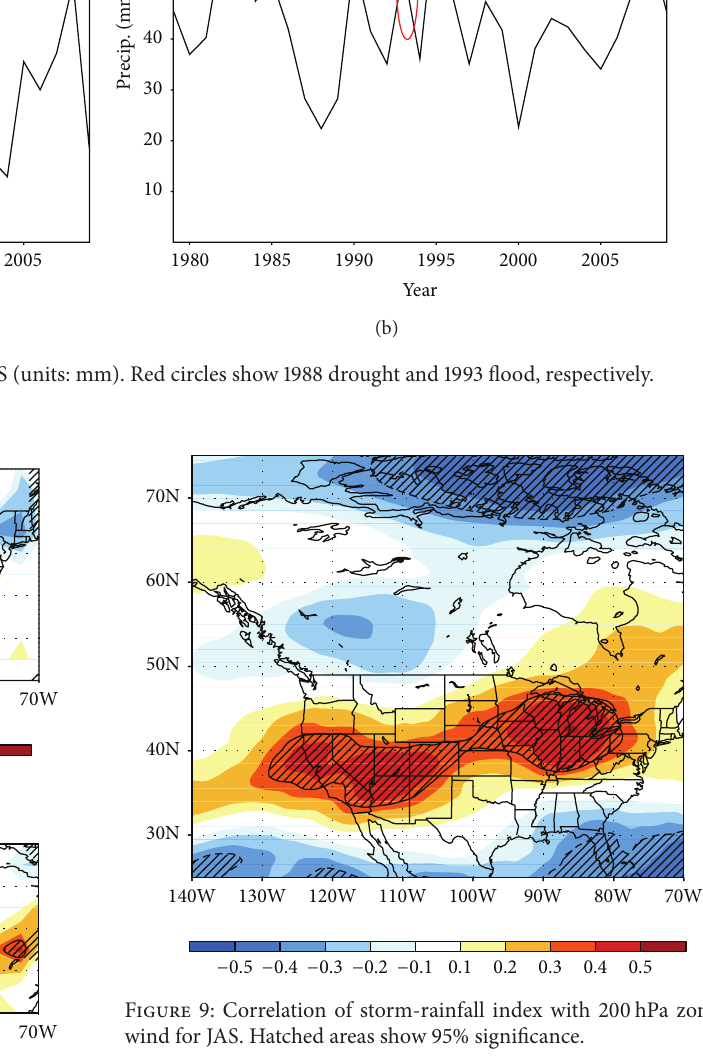
storm track frequency differences in southwestern Canada (refer to Figure 4(b)).